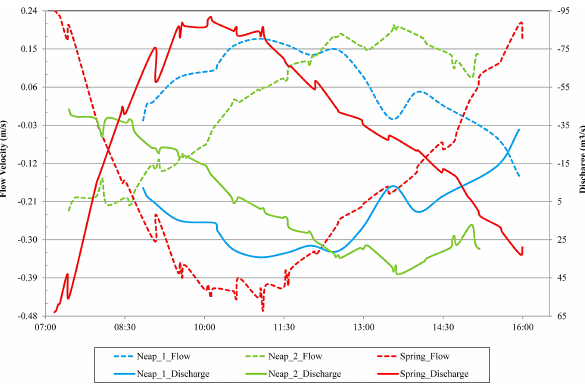
Fig. 5. Discharge and flow velocity measurements across the creek width at VMR